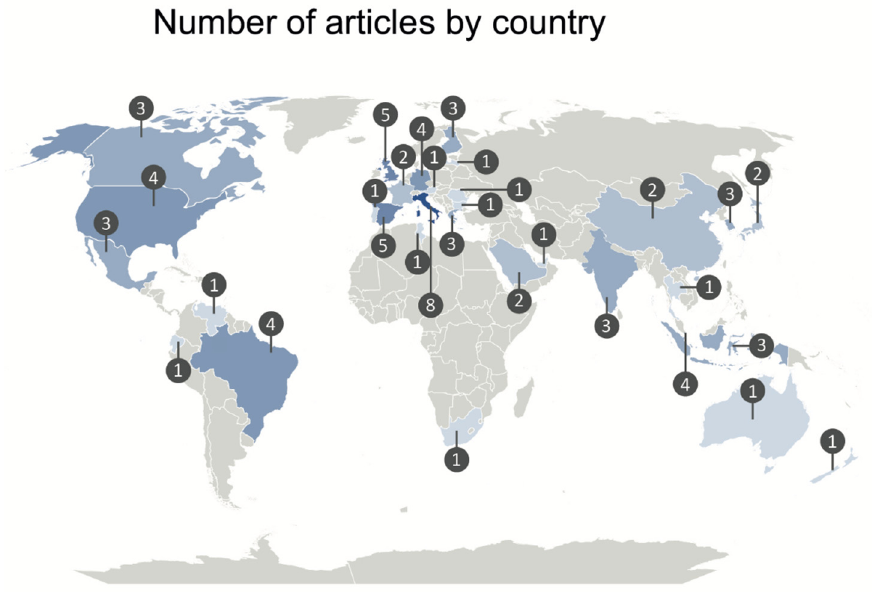
Figure 3. Distribution of the selected studies by